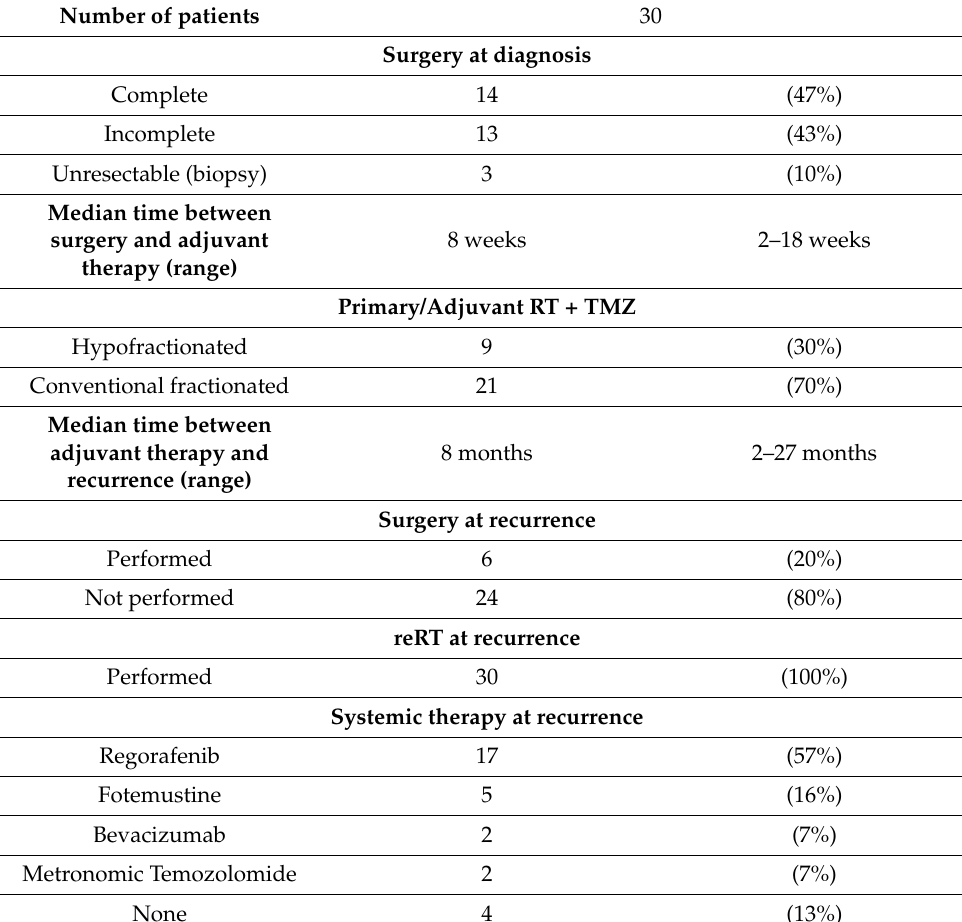
Table 2. Treatment characteristics for all